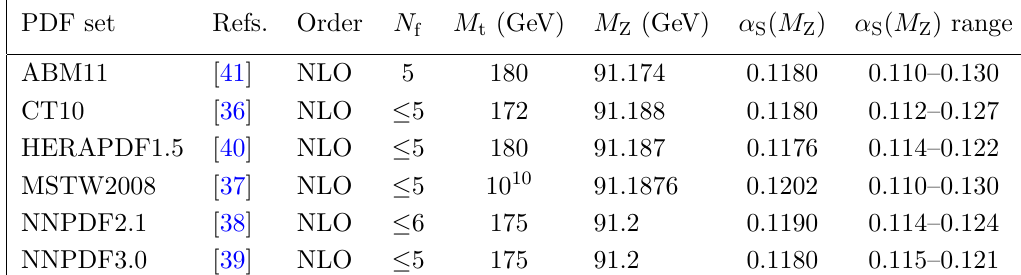
Table 2 . The PDF sets used in comparisons to the data together with the corresponding number of active (cid:13)avours N f , the assumed masses M t and M Z of the top quark and Z boson, the default values of the strong coupling constant (cid:11) S ( M Z ), and the ranges in (cid:11) S ( M Z ) available for (cid:12)ts. For CT10 the updated versions of 2012 are